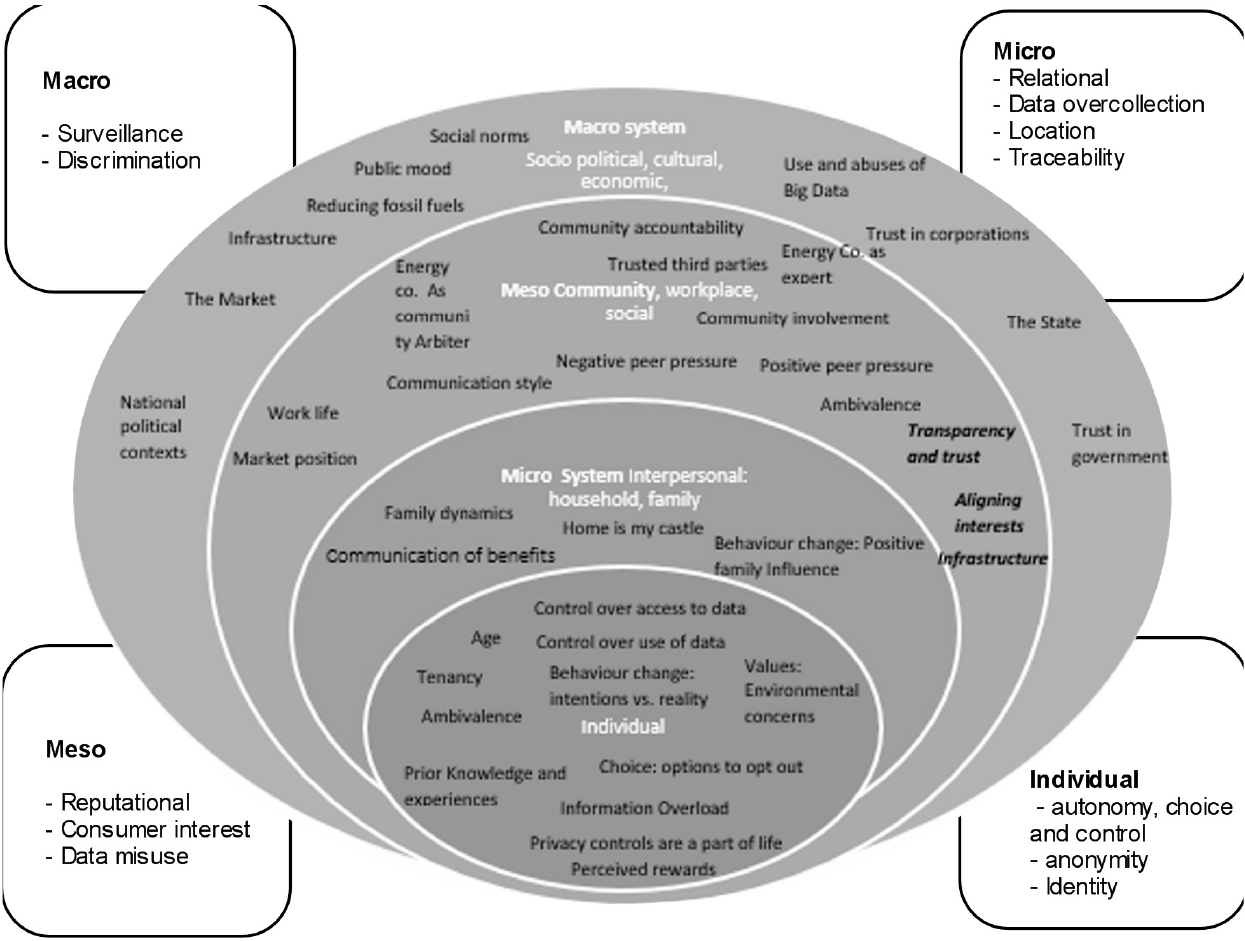
Figure 3. Privacy concerns, barriers, and facilitators to data sharing by the socio–ecological model of human development